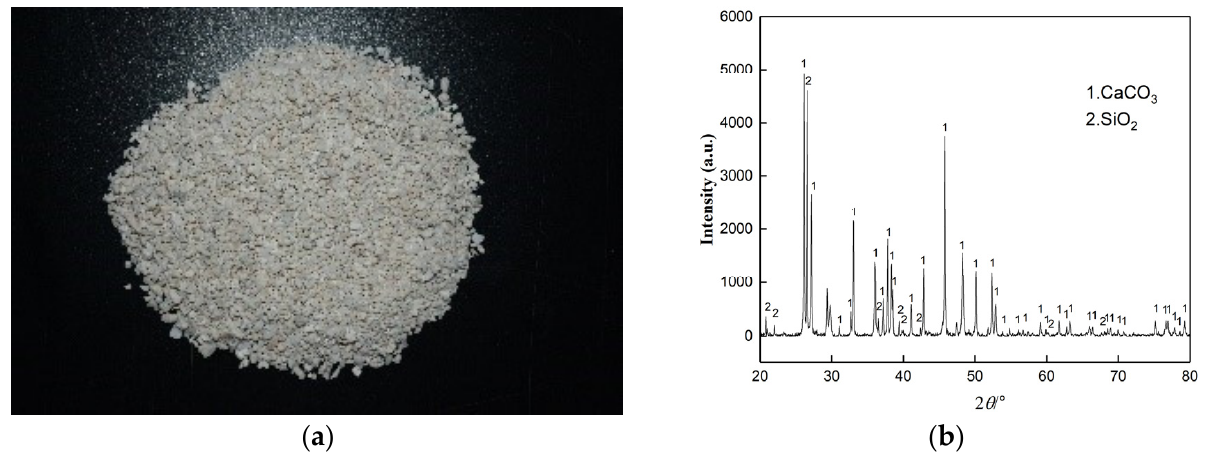
Figure 2. Samples: ( a ) Calcareous sandstone samples used in this study (particle size = 0.075–5 mm); ( b ) XRD spectra.